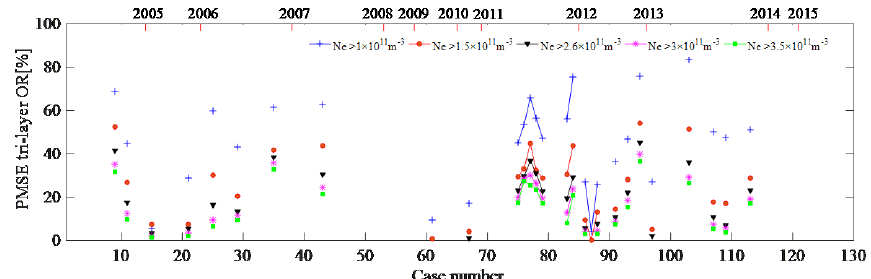
Figure 7. PMSE tri-layer occurrence ratio under different electron density thresholds, with the axis at the top showing the time in years.